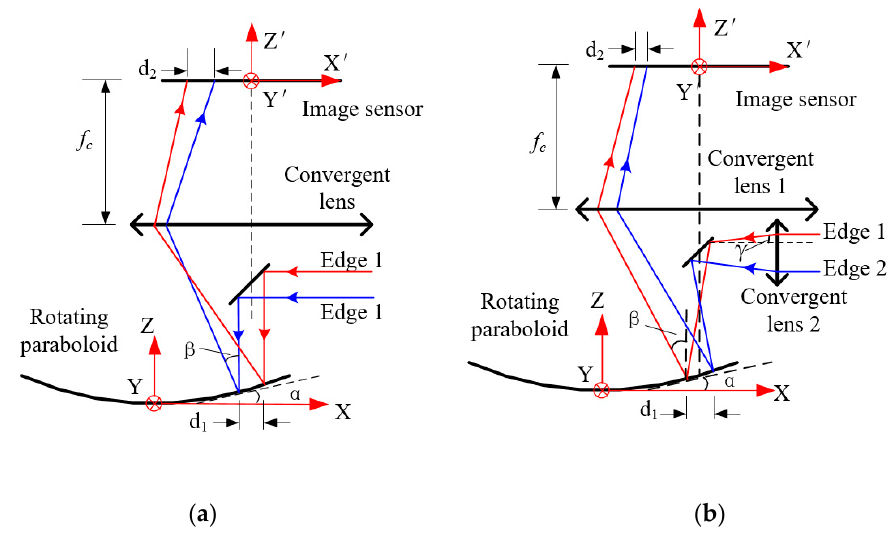
Figure 5. Measurement system using different types of beam: ( a ) Measurement system using a collimated beam; ( b ) measurement system using a focused beam.